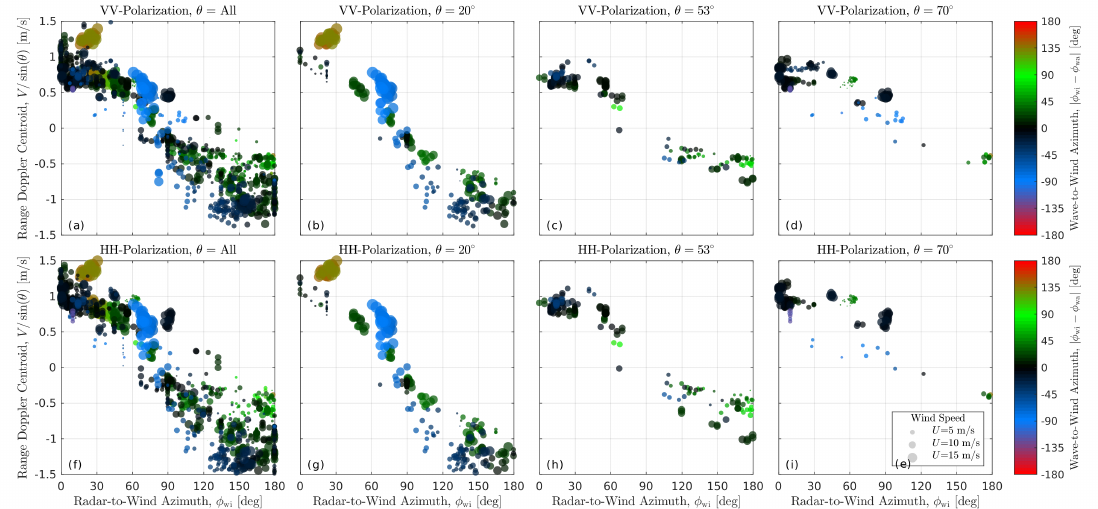
Figure 4. Doppler centroids versus radar-to-wind azimuth for ( top row ) VV polarization and ( bottom row ) HH polarization at ( a , f ) all incidence angles, ( b , g ) θ = 20 ◦ , ( c , h ) θ = 53 ◦ , and ( d , i ) θ = 70 ◦ . Color scheme corresponds to wave-to-wind azimuth. Symbol size corresponds to wind speed. All conditions, including non-aligned winds and waves, are